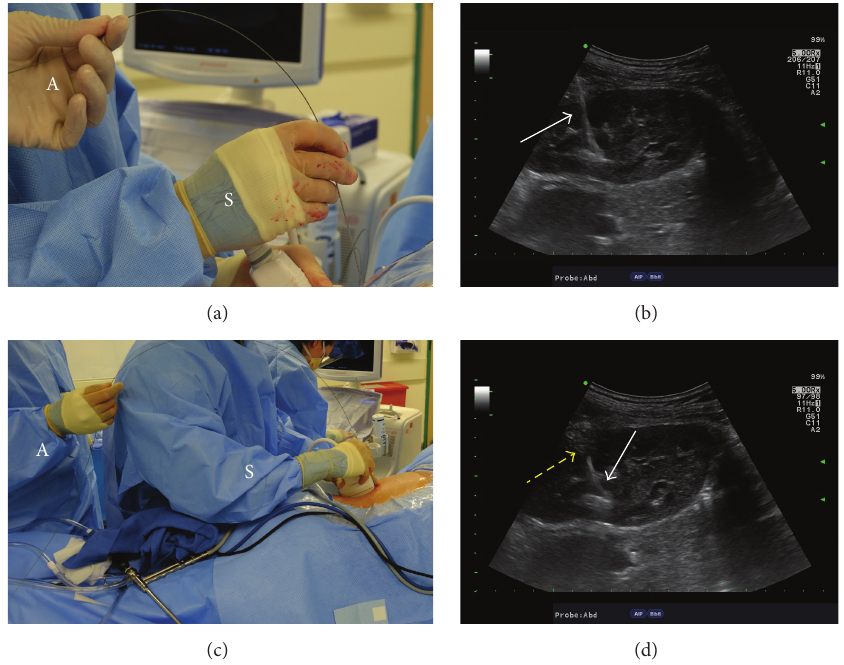
Figure 2: Introduction of working wire and dilators using ultrasound guidance. (a) A J-tip coaxial wire is inserted through the needle after its tip is confirmed in the collecting system. The operative surgeon (S) controls the needle with dominant hand and holds the ultrasound probe with the nondominant hand while the assistant (A) controls the wire. (b) Ultrasonographic image of the kidney demonstrating the wire (white arrow) in the collecting system after needle withdrawal. Its appearance is highly echogenic and prominent. (c) For fascial dilation, a 10-French fascial dilator is passed over the wire. Again, the operative surgeon (S) holds the ultrasound probe and controls the dilator while the assistant (A) controls the wire. (d) As the fascial dilator passes over the working wire, the wire is seen very clearly as an echogenic line (white arrow). The dilator obscures the view of the wire and this interface of the echogenic wire and the area where the wire disappears from view is the tip of the fascial dilator (yellow